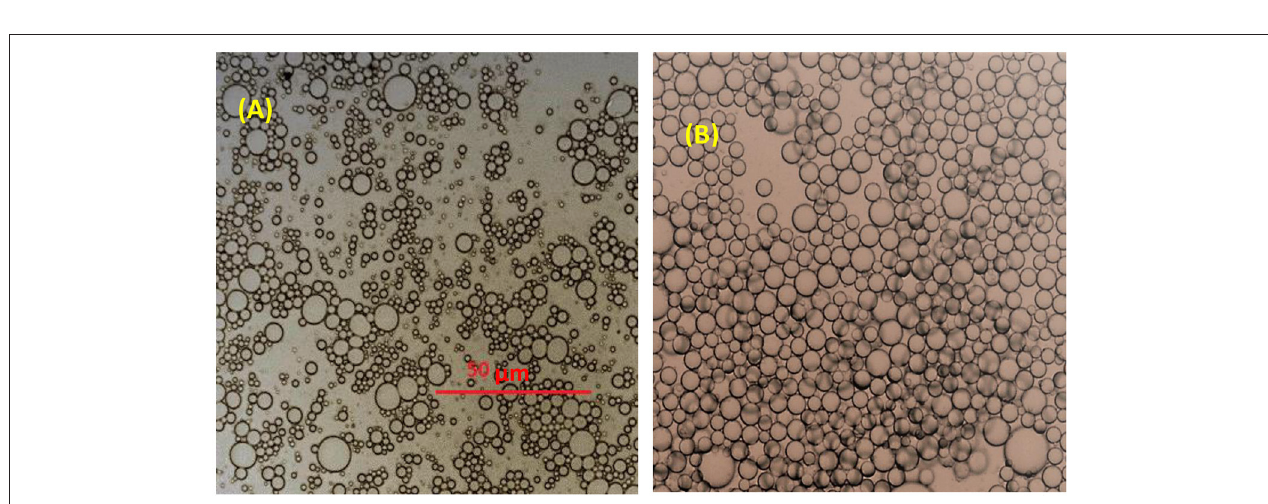
FIGURE 3 | Photographs of CNC stabilized C. Oil/water emulsion after centrifugation. (a) Low CNC concentrations and (b) high CNC concentrations.